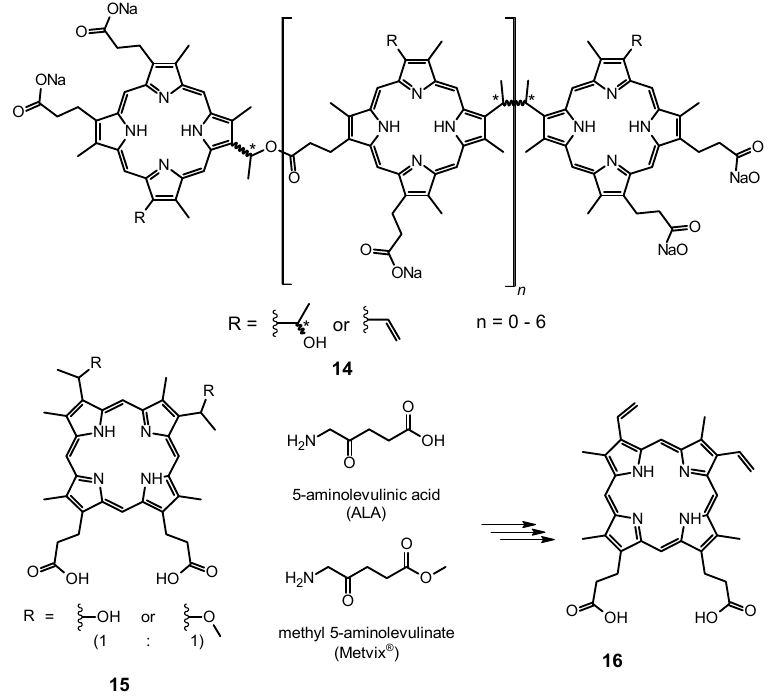
Figure 5. Chemical structure of 14 –